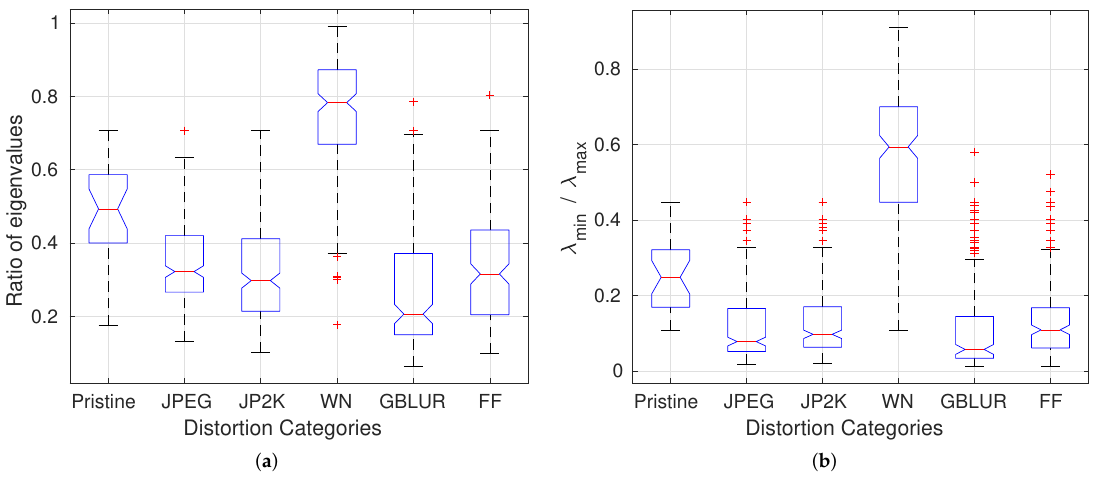
Figure 7. Boxplots of the ratio of the minimum and maximum eigenvalues of the estimated covariance matrix Σ of ( a ) two-dimensional MVGG fit and ( b ) five-dimensional MVGG fit over all reference and distorted images from the LIVE database; “WN” is white noise; “GBLUR” is Gaussian blur; and “FF” is fast fading Rayleigh channel.